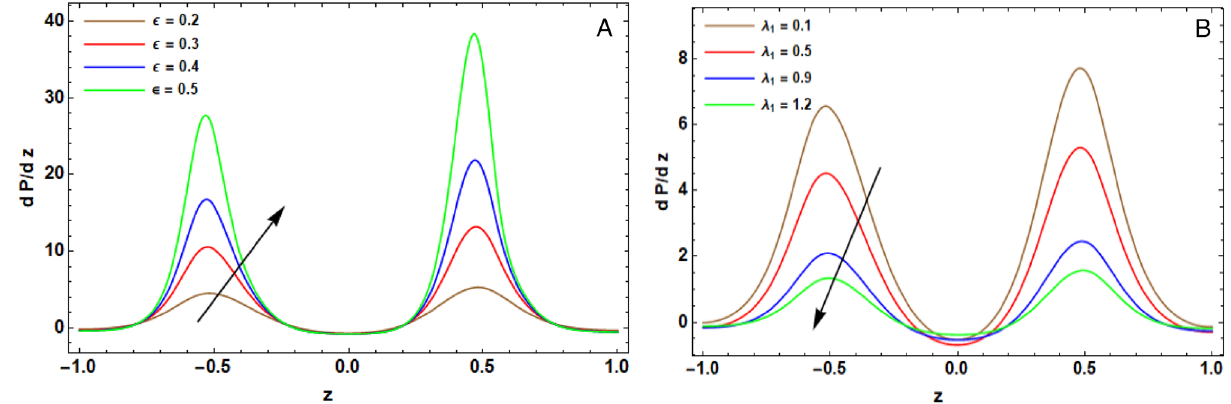
Figure 7. ( A ) implies alteration of dP dz for diverse amounts of ǫ . ( B ) implies alteration of dP dz for diverse amounts of (cid:31) 1